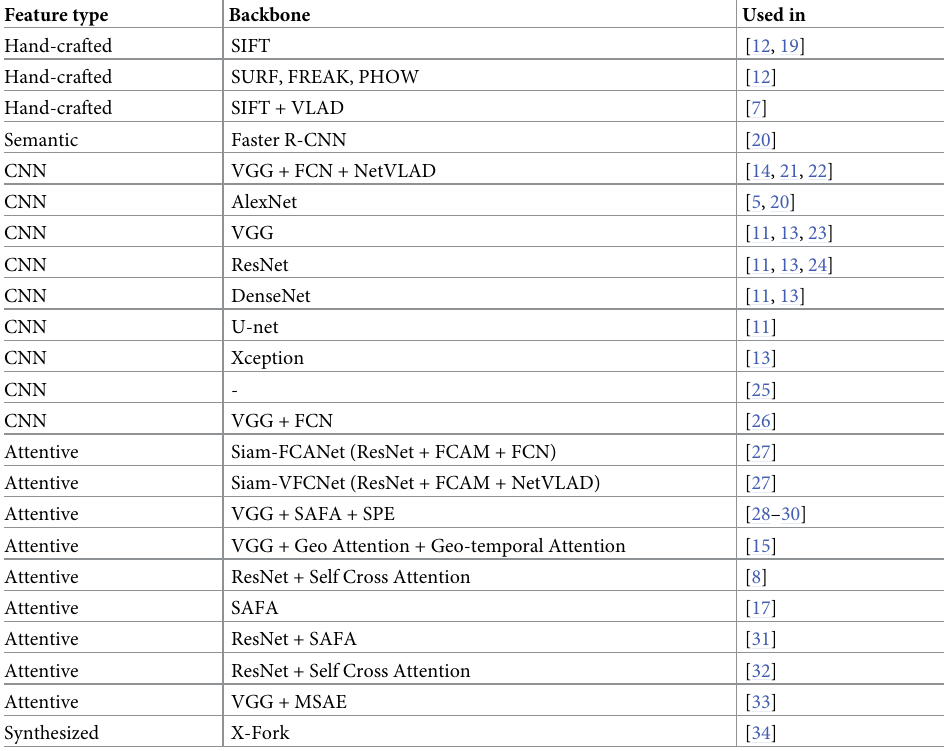
Table 1. A summary of the feature types and the backbones of different cross-view geo-localization networks. Feature type Backbone Used